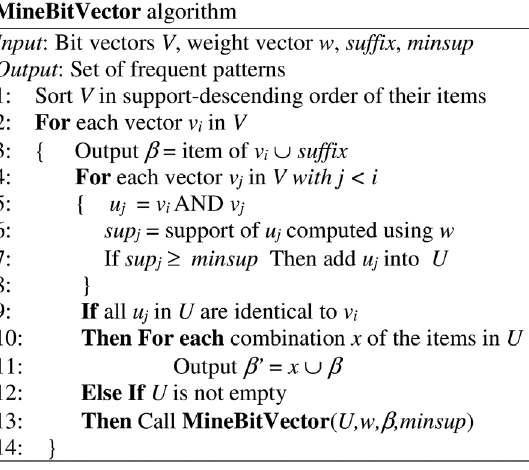
Figure 7. MineBitVector Algorithm.